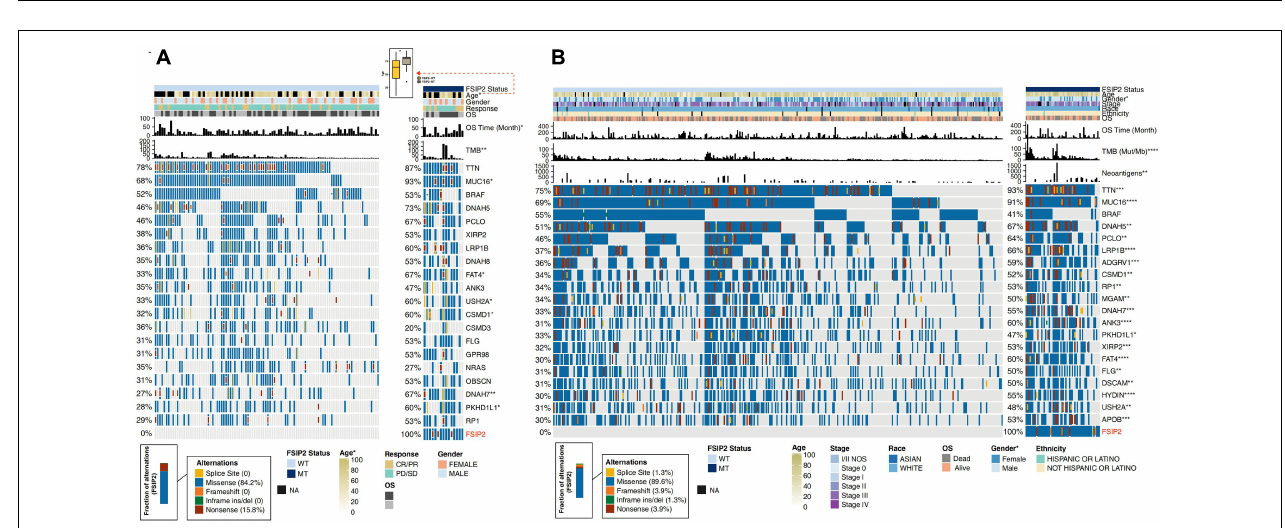
FIGURE 2 | Clinical characteristics and gene mutation panoramas of SKCM patients in the ICI-treated and TCGA-SKCM cohorts. The acquired ICI-treated and TCGA-SKCM cohorts were divided into an FSIP2-MT group and FSIP2-WT group according to the FSIP2 mutation status. (A) . We performed Fisher’s exact test on the FSIP2-WT and FSIP2-MT groups of the ICI-treated cohort based on age, sex, treatment response, overall survival and TMB. Except for a higher average age, longer OS time and higher TMB in the FSIP2-MT group, there were no significant differences between the two groups. A comparative analysis of the top 20 mutated genes showed that there were significant differences between the two groups in the mutation frequencies of the MUC16, FATA4, USH2A, CSMD1, DNAH7, and PKHD1L1 genes. The mutation types of the FSIP2 gene were mainly missense mutations (84.2%) and nonsense mutations (15.8%). (B) . We performed Fisher’s exact test on the FSIP2-WT and FSIP2-MT groups of the TCGA-SKCM cohort based on age, sex, disease stage, ethnicity, race, overall survival, TMB and neoantigen load. Except for patient sex, TMB and NAL, no parameters showed significant differences between the two groups. A comparative analysis of the top 20 mutated genes showed that, except for the BRAF gene, none of the remaining 19 genes exhibited significant differences in mutation status. The main mutation type of the FSIP2 gene was missense mutation (89.6%), and the other types were splice site (1.3%), frame shift (3.9%), inframe ins/del (1.3%) and nonsense (3.9%) mutations (* p < 0.05; ** p < 0.01; *** p < 0.001; **** p <